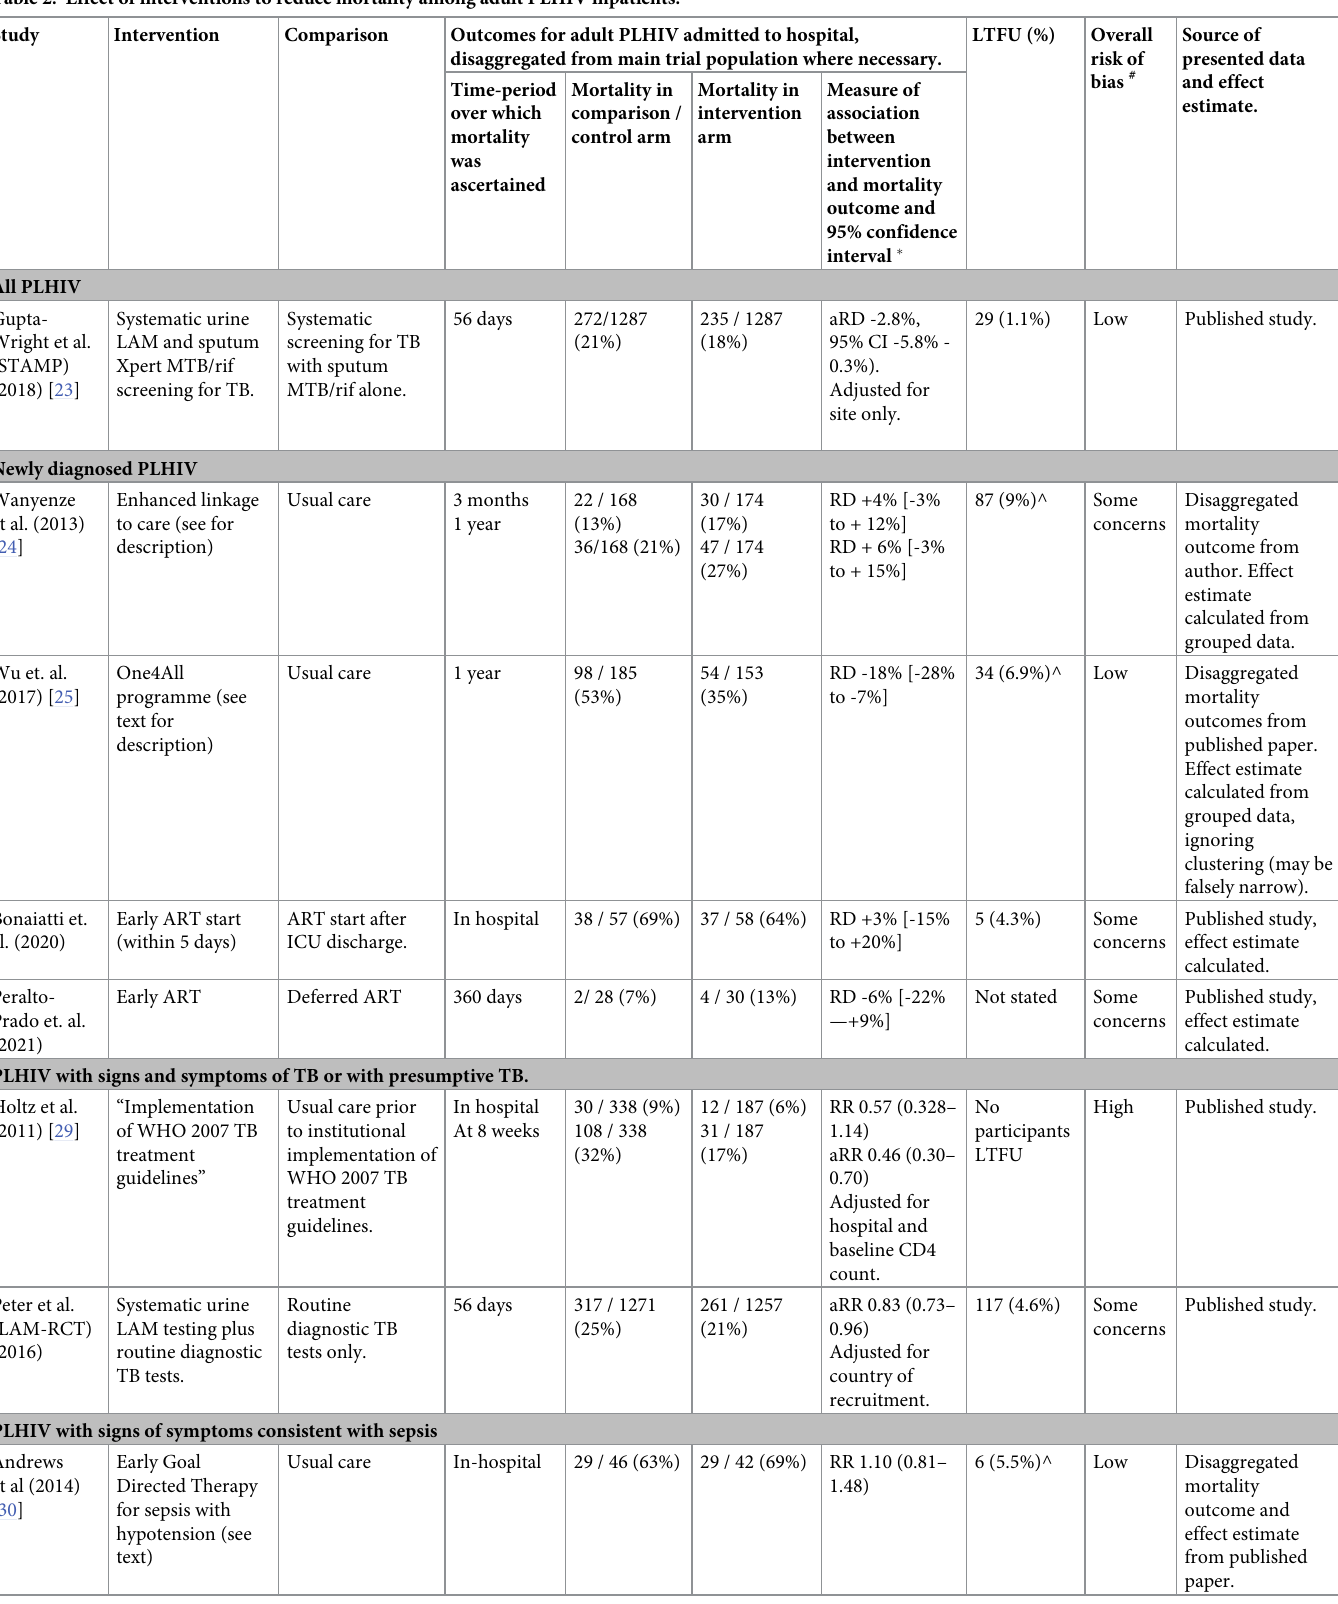
Table 2. Effect of interventions to reduce mortality among adult PLHIV